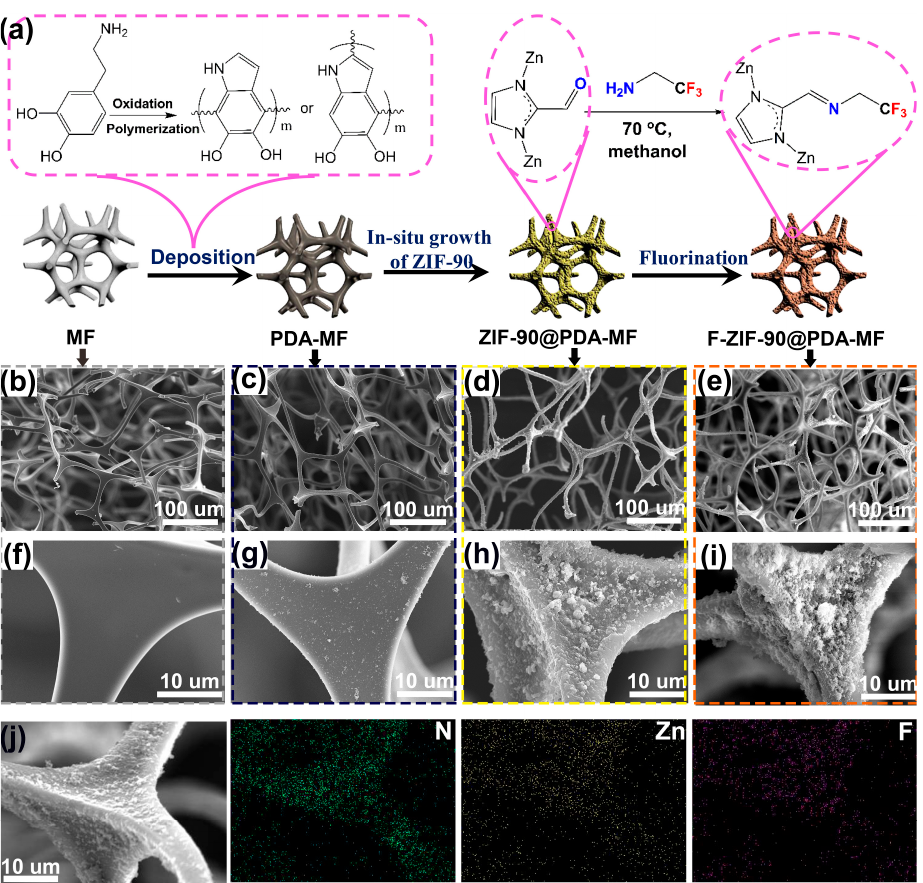
Figure 1. ( a ) Schematic illustration for the fabrication process of F-Zeolitic imidazolate frameworks -90/polydopamine-melamine formaldehyde (F-ZIF-90@PDA-MF). Scanning electron microscope (SEM) images for ( b , f ) pristine MF, ( c , g ) MF-PDA ( d , h ) ZIF-90@PDA-MF and ( e , i ) F-ZIF-90@PDA-MF. ( j ) Ele- ment mapping images of